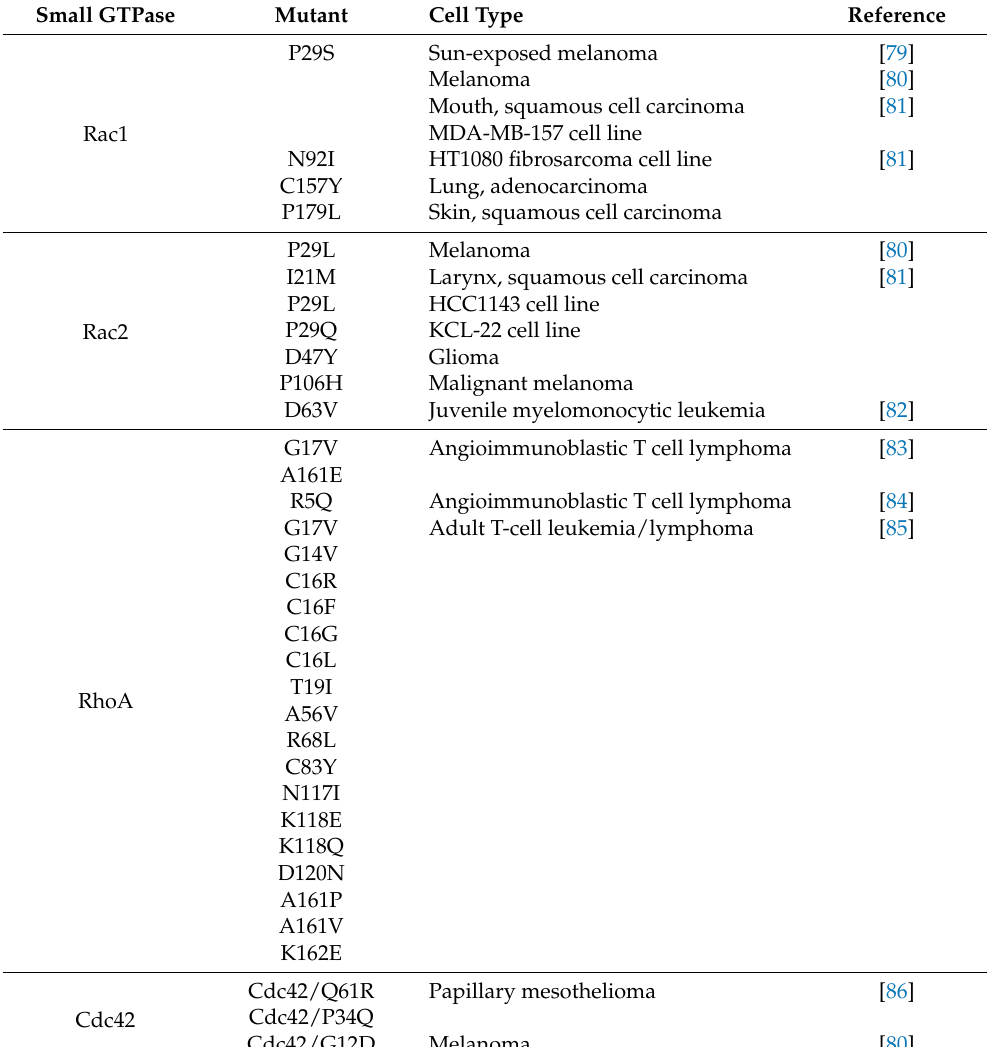
Table 2. Known cancer-associated mutants of Rac1, Rac2, RhoA, and